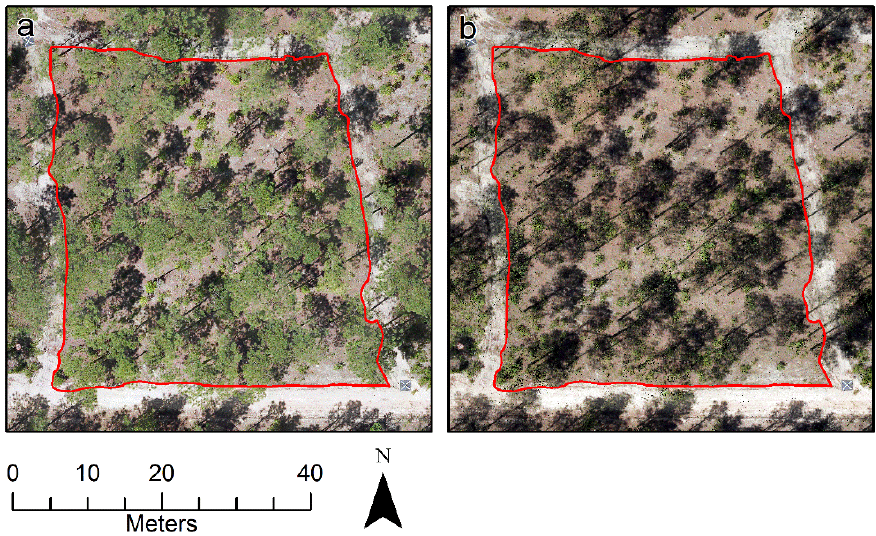
Figure 5. UAV imagery of unit 16D1 captured in RGB ( a ) prior to digital removal of tree crowns and ( b ) after digital removal of tree crowns. Dark regions in ( b ) are largely tree shadows which remain.